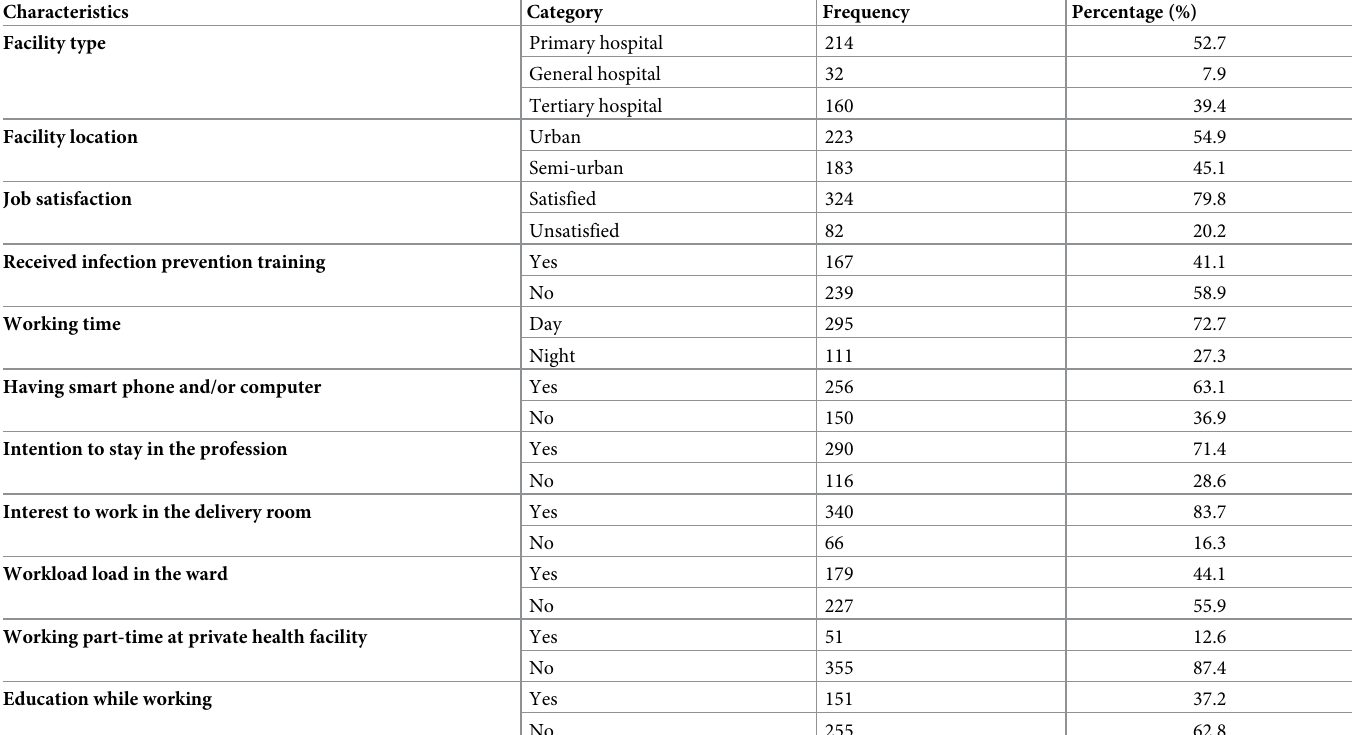
Table 2. Workplace and profession related characteristics of study participants in hospitals of Gondar province, northwest Ethiopia, 2020/2021 (n = 406).